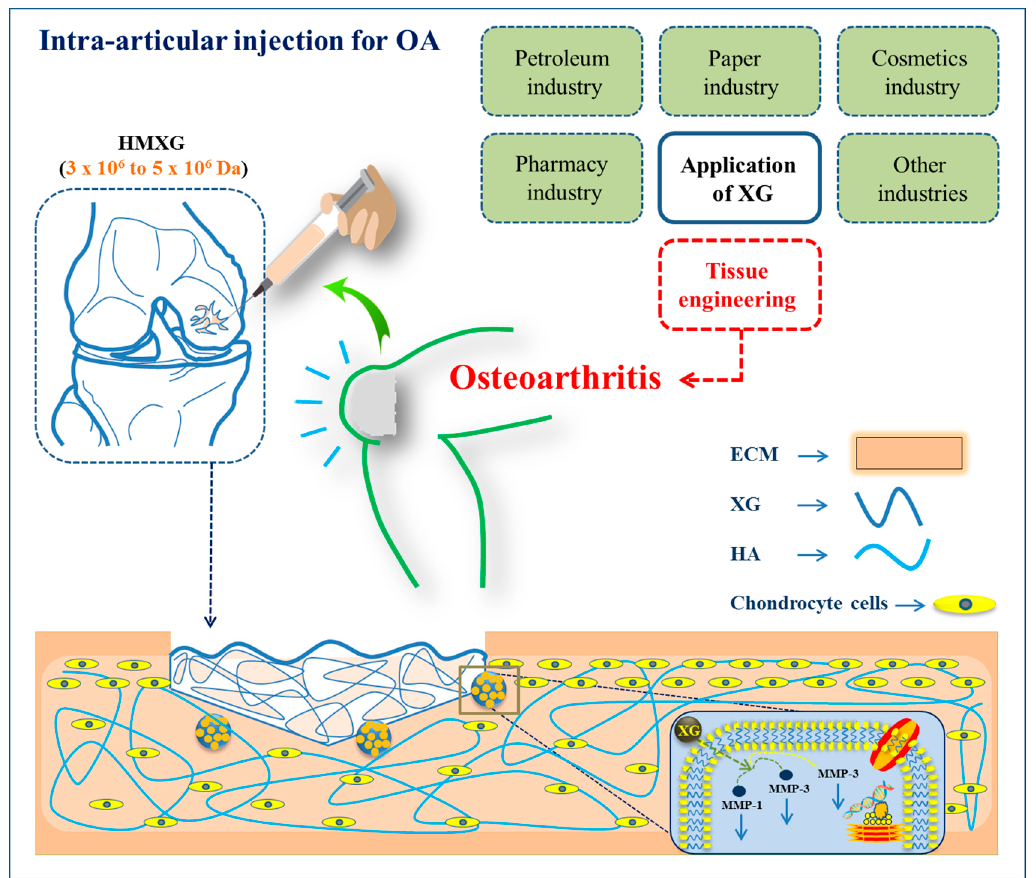
Figure 4. Schematic representation of various industrial applications along with tissue engineering application of xanthan gum (XG) and the preparation of HWXG intra-articular injection for osteoarthritis therapy by suggesting mechanism [173].